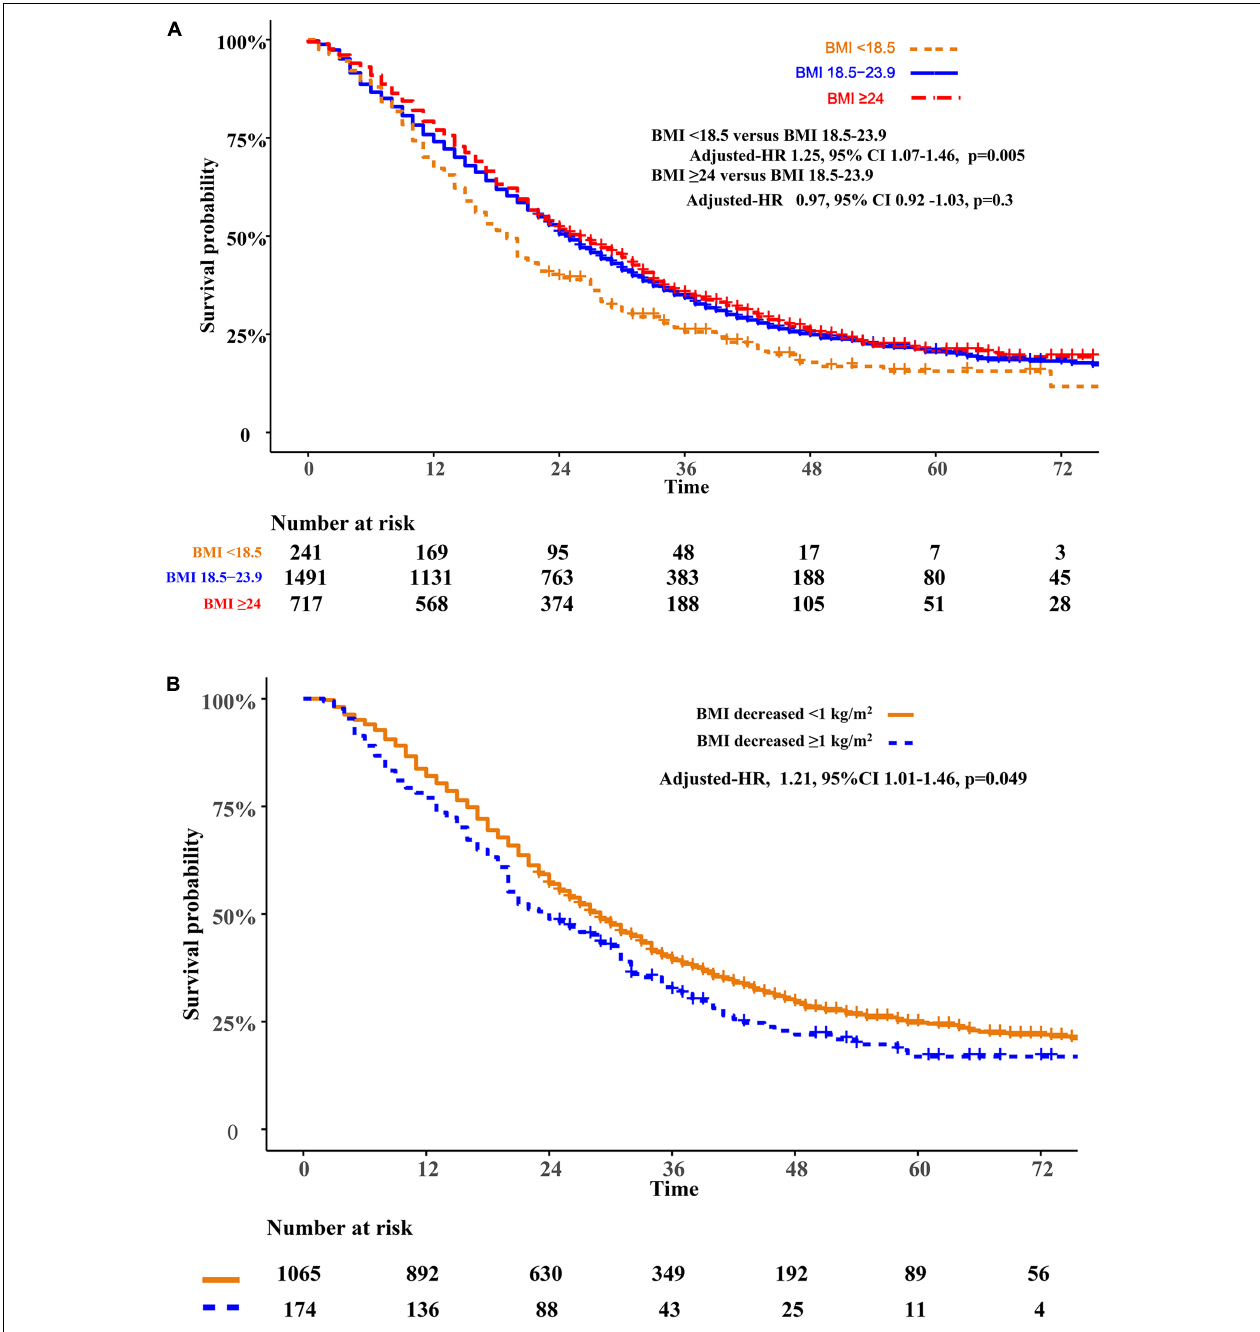
FIGURE 2 | Overall survival comparisons of BMI (A) and weight change (B) . BMI, body mass index (recorded when brain metastases was